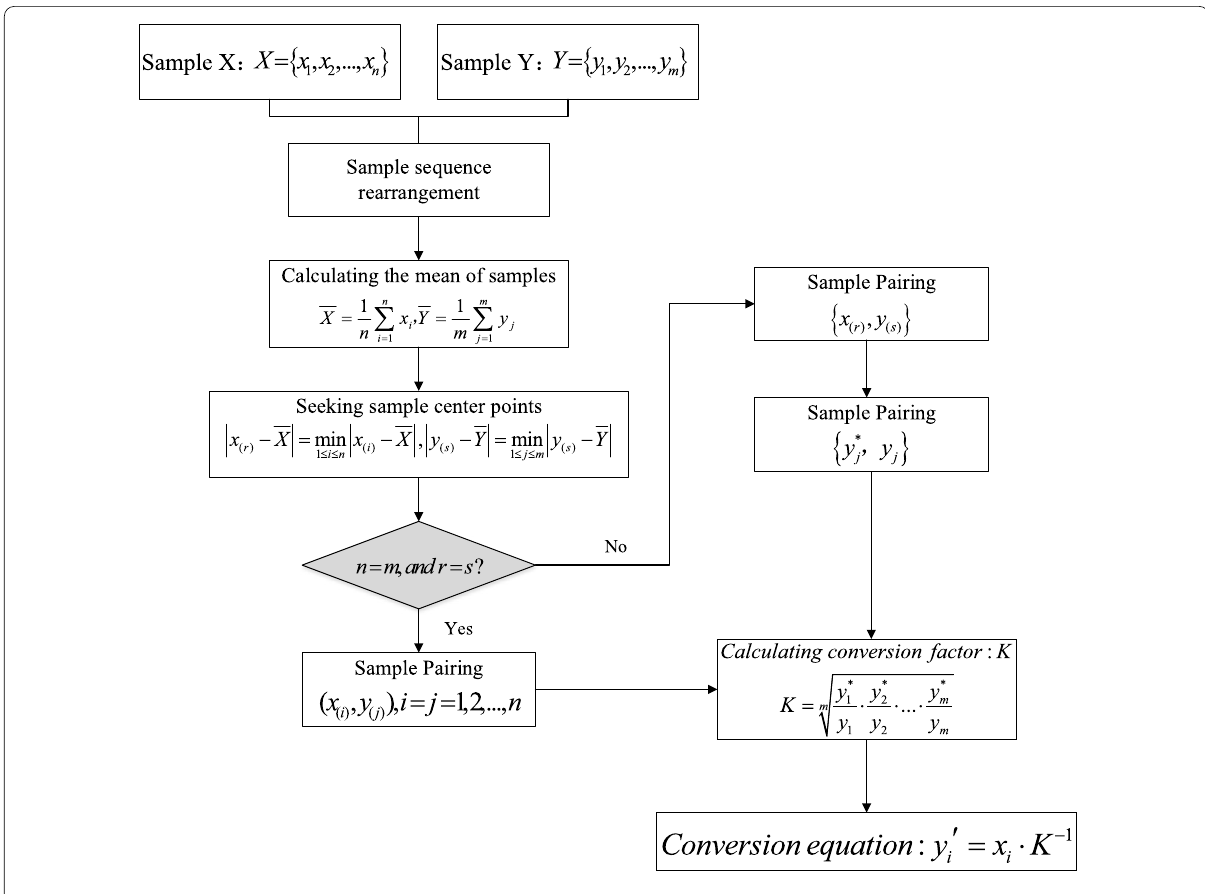
Figure 1 Information conversion process based on Fisher algorithm